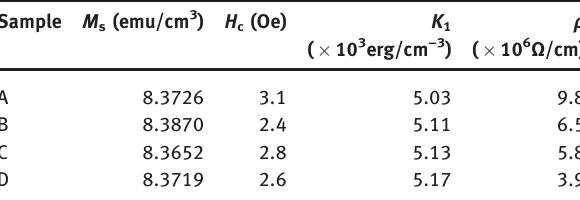
Table 3: Saturation magnetization ( M s ), coercive field ( H c ), magnetocrystalline anisotropy ( K 1 ) and resistivity ( ρ ) for the